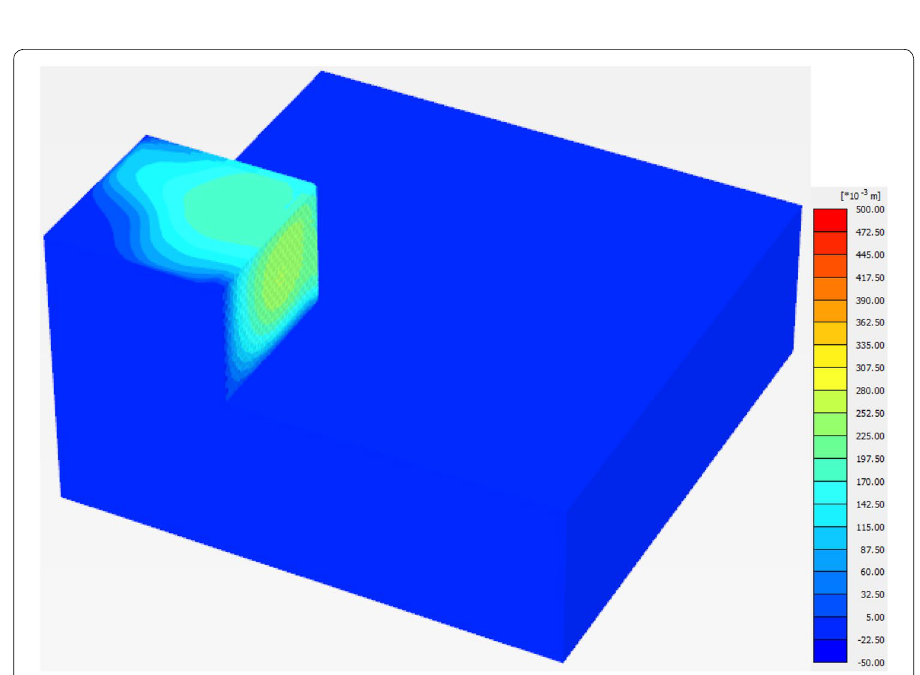
Fig. 18 Horizontal displacement contour of Case